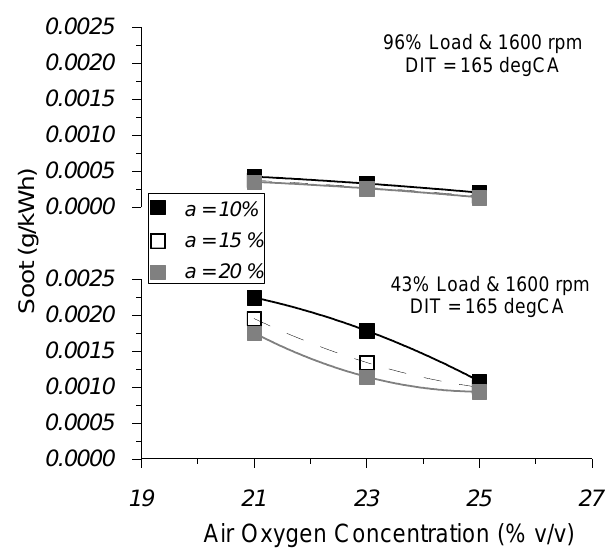
Figure 14. Calculated specific Soot concentration versus “inlet-air oxygen ratio” for various “diesel fuel quantity ratios”, at 43% and 96% of engine rated load and 1600 rpm engine speed, for DIT = 165 degCA.